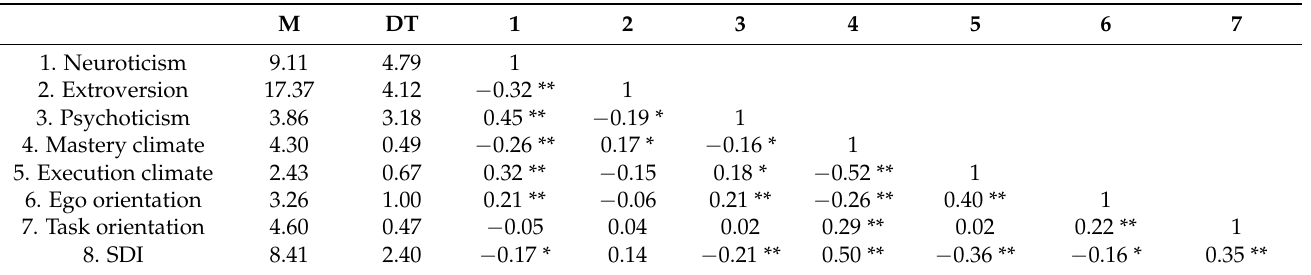
Table 1. Descriptive analyses and bivariate